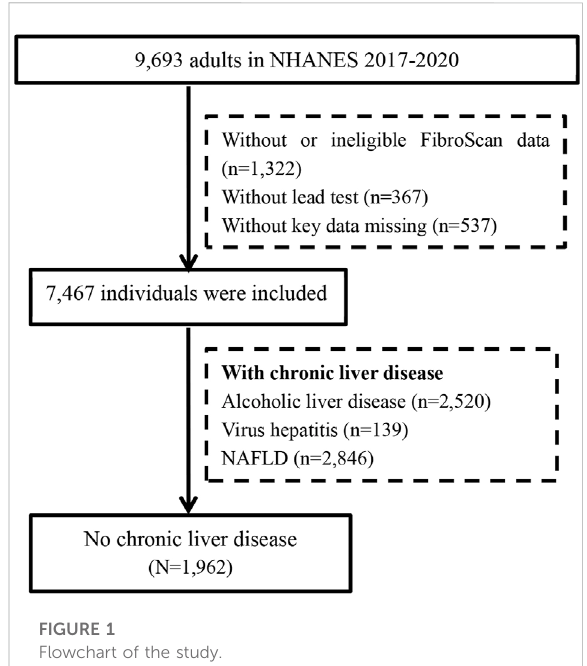
FIGURE 1 Flowchart of the